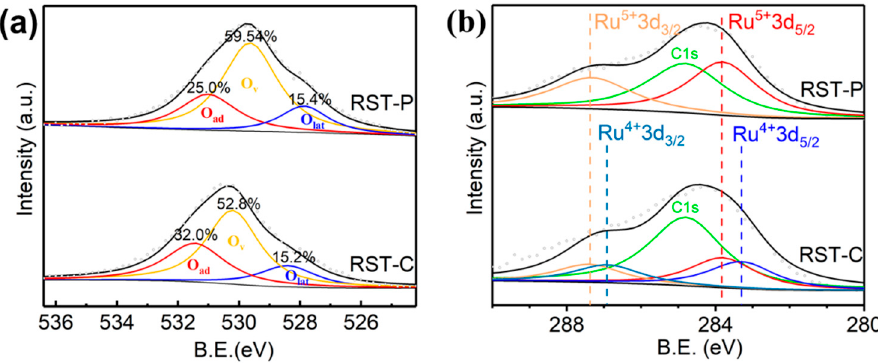
Figure 4. XPS data of ( a ) O 1s and ( b ) Ru 3d for the RST catalysts .